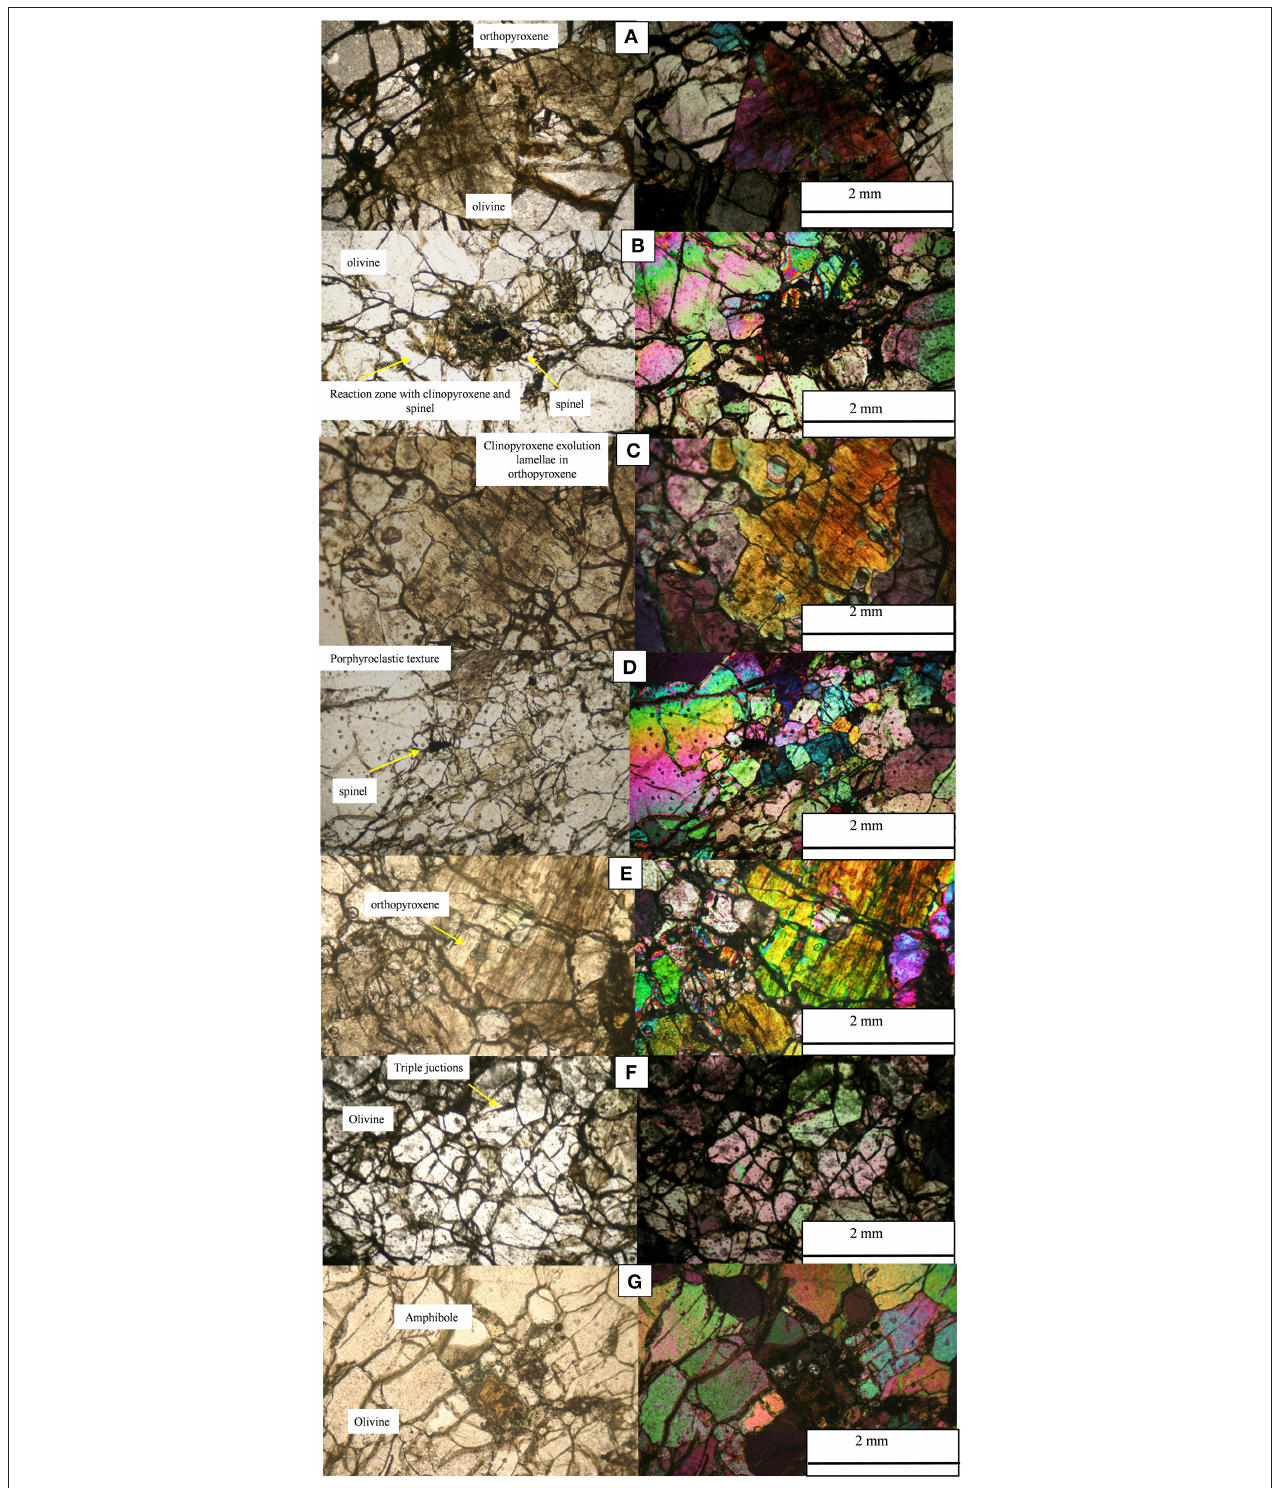
FIGURE 2 | (A–G) Photomicrographs of representative microstructures of WG xenoliths in transmitted plane-polarized light (left) and in cross-polarized light (right). In detail: (A,B) images showing protogranular textures with large Opx and Ol grains (WG4 II ); (B) a reaction zone with the spongy rims of Cpx and spinel (WG1 II ); (C) a protogranular texture with large Opx hosting Cpx exsolution lamellae (WG9 II ); (D) examples of porphyroclastic textures with Ol neoblasts slightly oriented and with small Ol replacing large Opx; (E) Large opx and small equigranular ol in WGII8; (F) Equigranular texture with Ol converging at 120 degrees; (G) Small amphiboles associated with the spongy rim of Cpx. Bubbles are evident in Ol (WG7 II ; d).